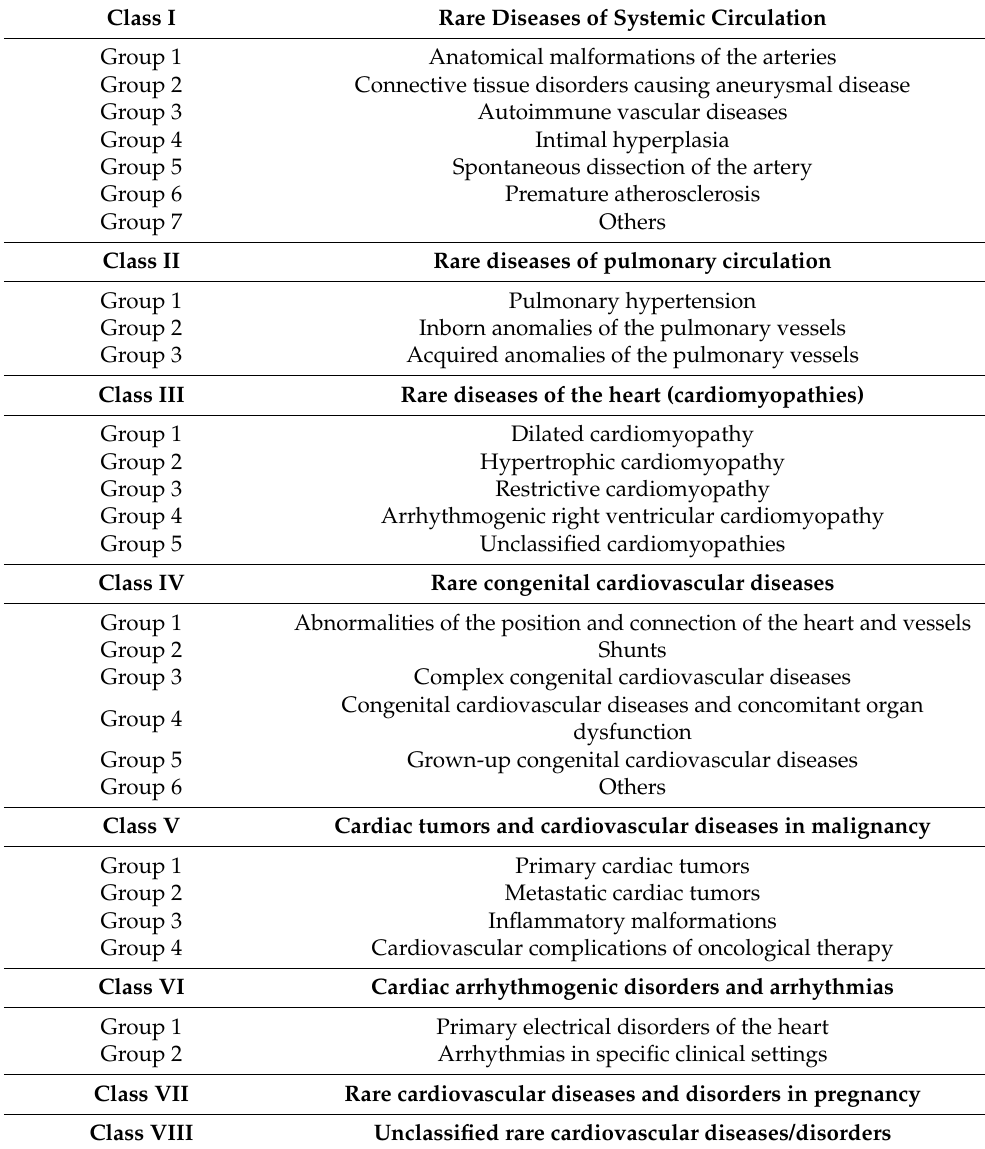
Table 1. Clinical classification of rare cardiovascular